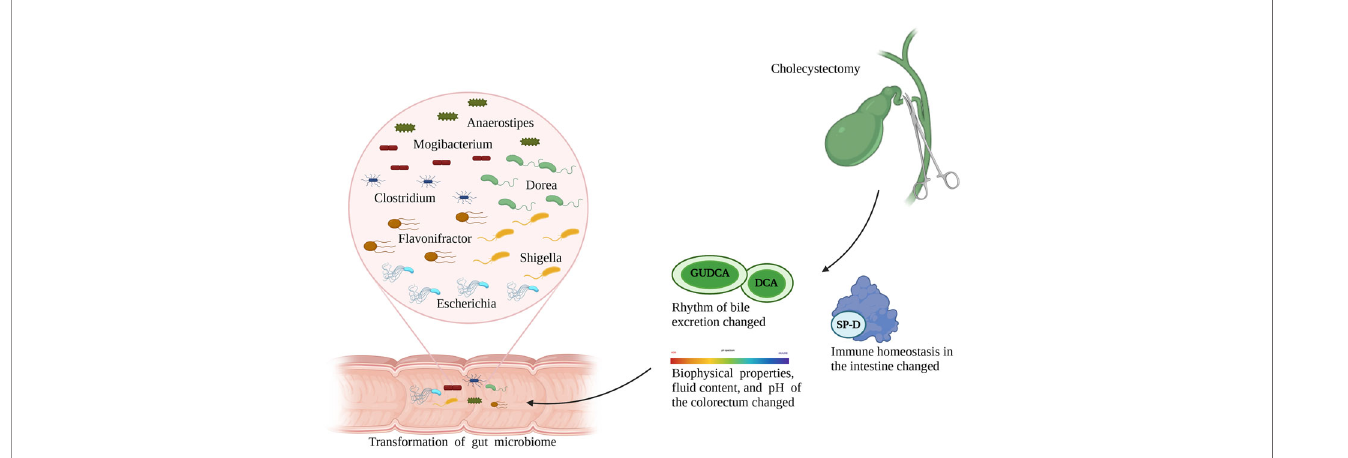
FIGURE 1 | Role of cholecystectomy in the alternation of gut